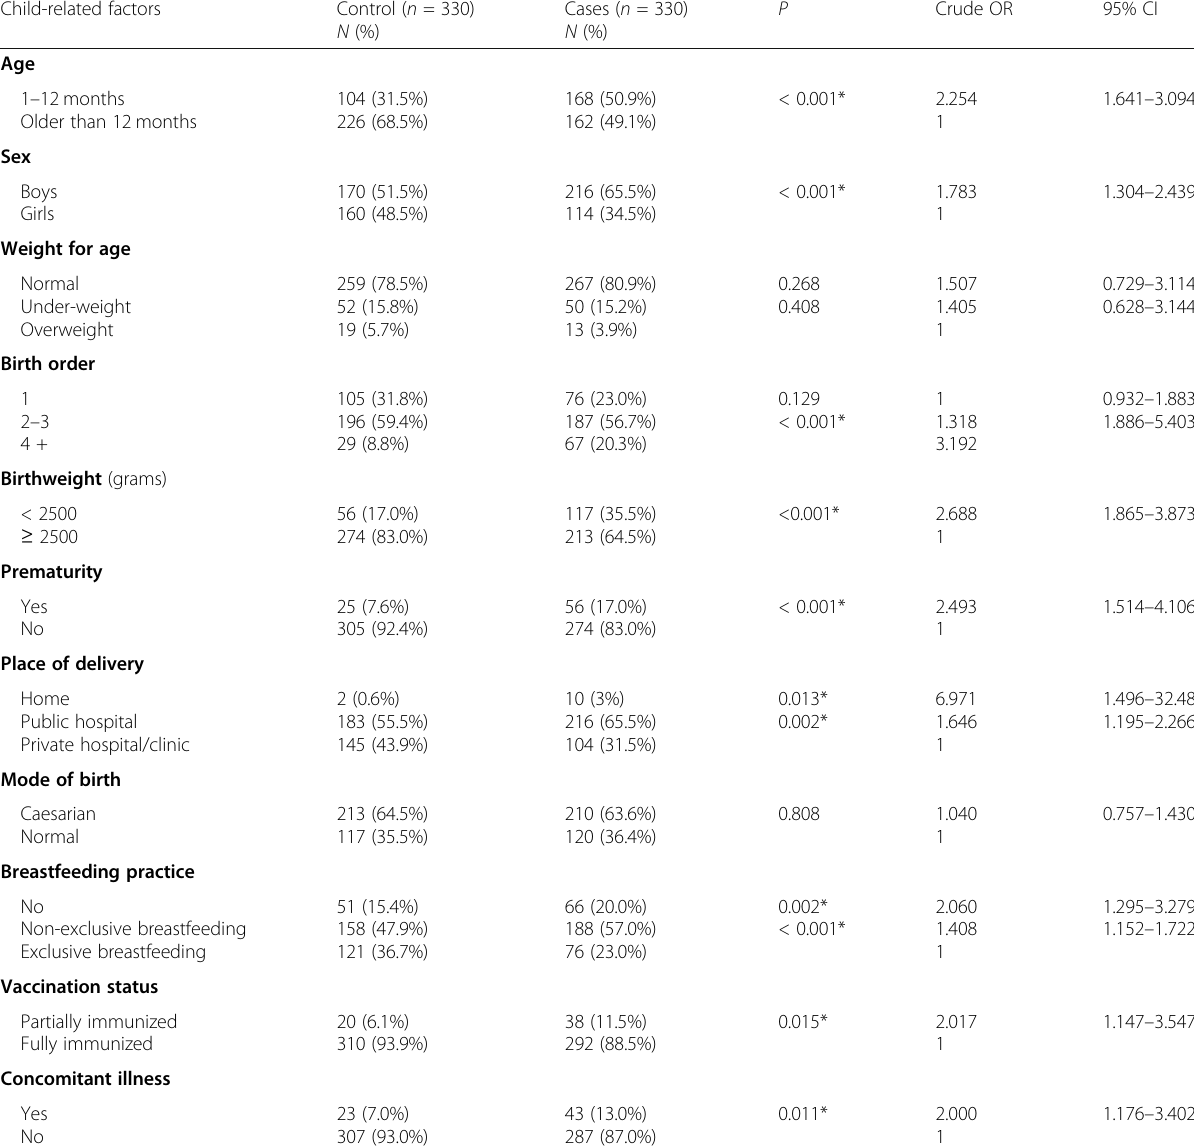
Table 1 Child-related factors associated with the risk of pneumonia among under-five children Child-related